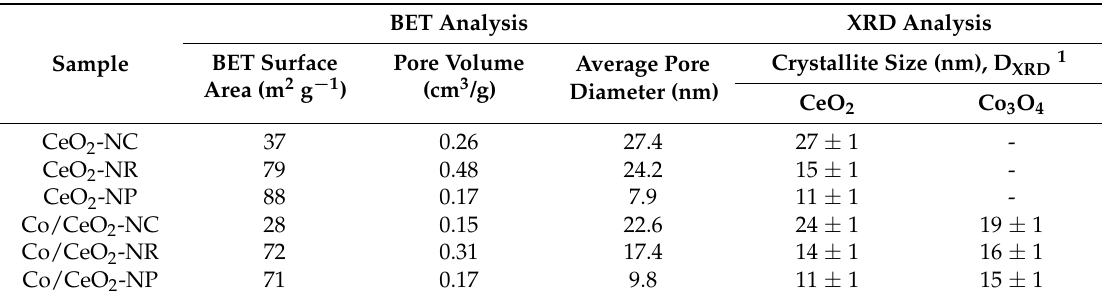
Table 1. The textural and structural properties of bare CeO 2 and Co/CeO 2